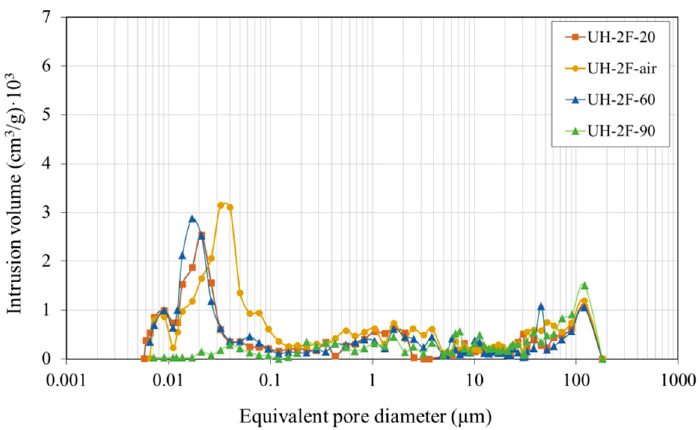
Figure 14. Pore size distribution.